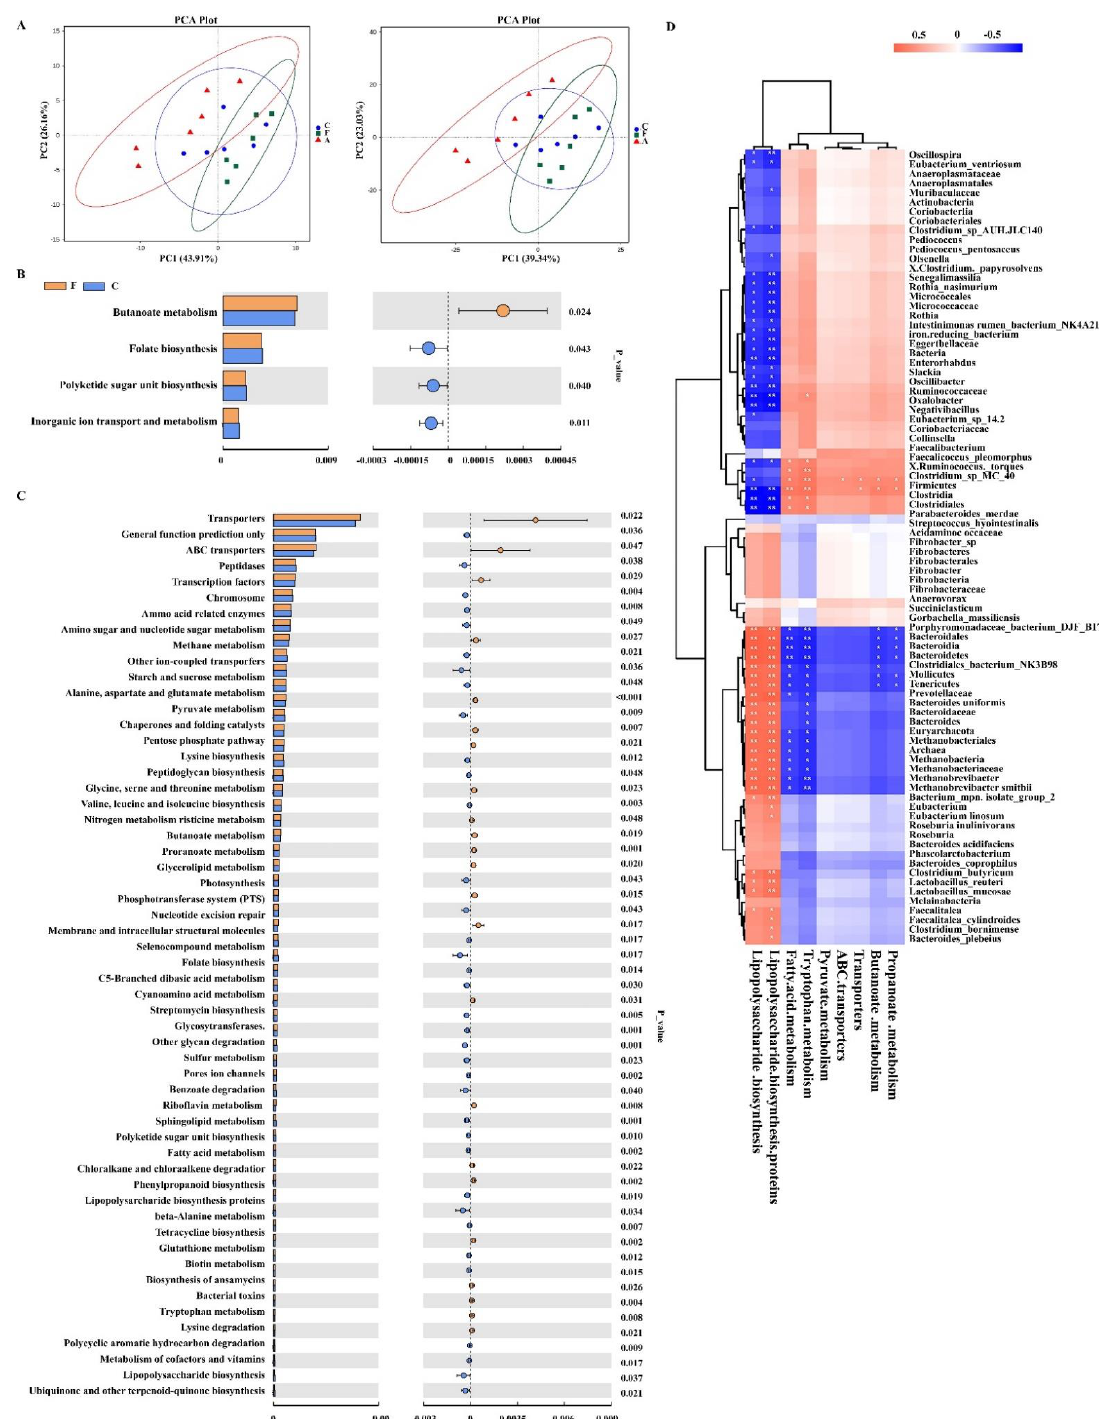
Figure 3. Functional metagenomics prediction and spearman’s correlation analysis of gut microbiota. ( A ) Scatter plot of Principal Component Analysis (PCA) based on Euclidean distances at level 2 and level 3. ( B ) Predictive functions of gut microbiota at the third level of the KEGG pathways between F group and C group. ( C ) Predictive functions of gut microbiota at the third level of the KEGG pathways between F group and A group. ( D ) Association analysis of specified predictive functions and microbiota with significant differences by Spearman correlation test. Red: positive correlation; Blue: negative correlation. C: control group, F: FAM group, A: antibiotic group. ** p < 0.01, * p < 0.05, blank represents no significant